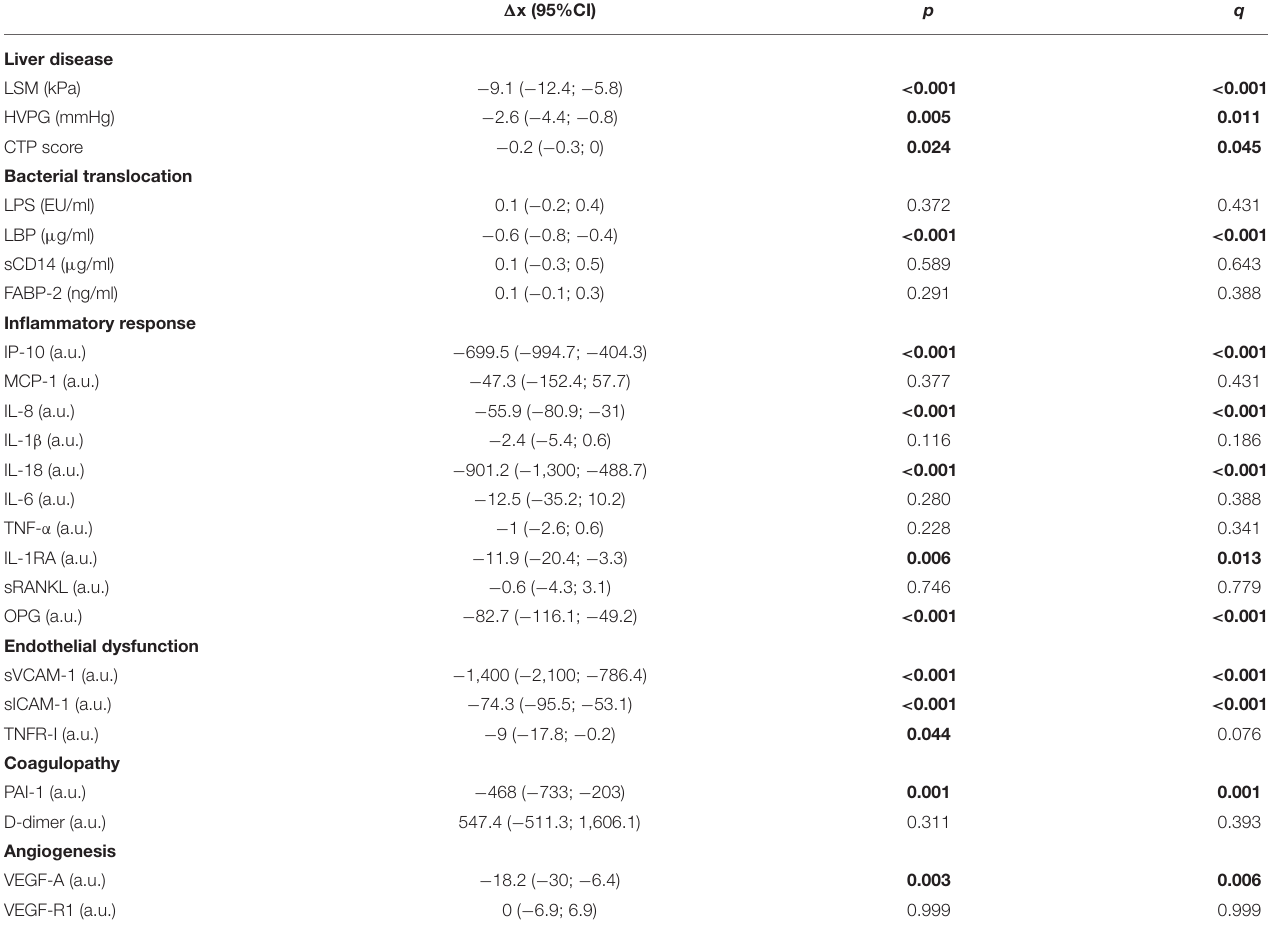
TABLE 2 | Change in severity scores of liver disease and plasma biomarkers during follow-up in HIV-infected patients with advanced HCV-related cirrhosis. 1 x (95%CI) p q Liver